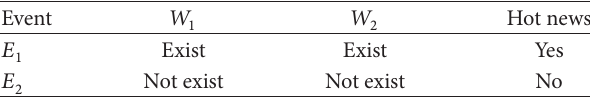
Table 1: High weight vocabulary and hot news.